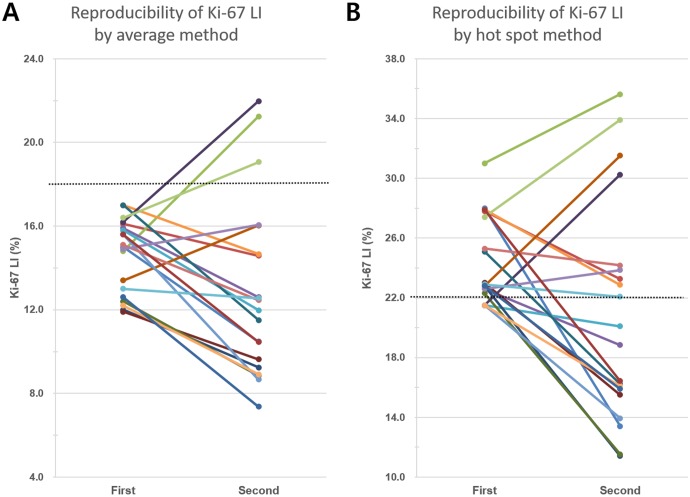
Variability of Ki-67 labeling index in repeated counts.(A) Twenty breast cancers that were initially classified into the low Ki-67 subgroup using the average method (cutoff value: 18%, dotted line) were re-counted by the same method. Only 3 cases were reclassified into the high Ki-67 subgroup in repeated count. (B) Of the 20 cases, 4 cases were initially classified into the low Ki-67 subgroup by the hot spot method (cutoff value: 22%, dot line). One of these was reclassified into the high Ki-67 subgroup, and 8 of the 16 cases originally classified into the high Ki-67 subgroup were reassigned to the low Ki-67 subgroup after a second count using the same method.